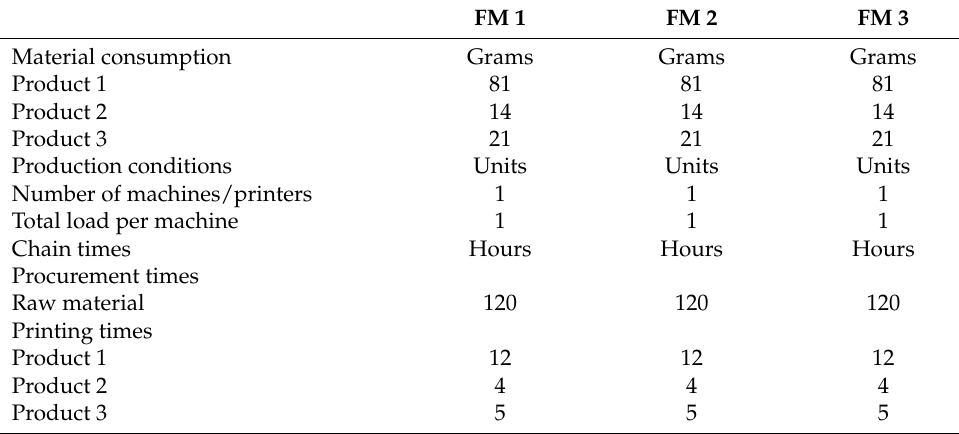
Table 10. Monthly order entry of the SC scenario with centralized